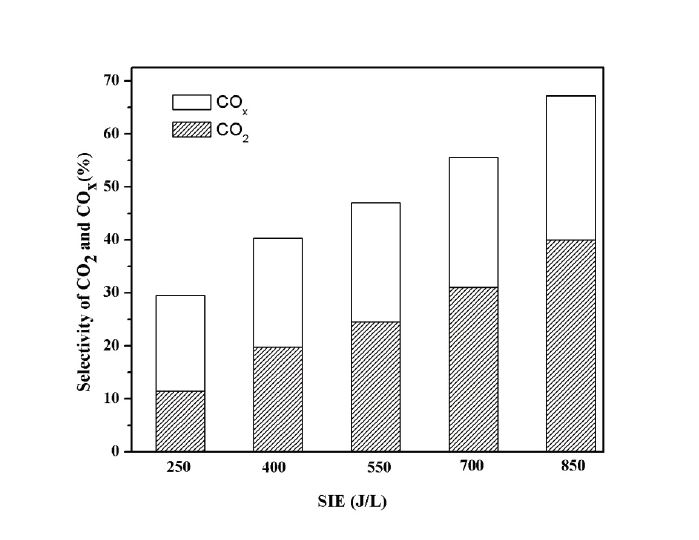
Figure 7. Selectivities of COx and CO 2 as a function of the specific input